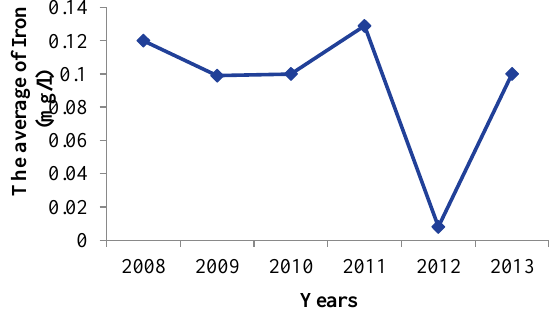
Figure 8. The average of Iron (mg/l) by year 2008-2013 In Birjand and Ghaen, Iran, the average levels of iron and manganese were 0.04 and 0.02 mg/l, respectively. 26 So, the amount of this cation was safe in drinking water in Fereidonkenar as well as Qom, 24 Birjand and Ghaen, 26 Ardebil, 27 Ilam (0.07 mg/l), and Shush and Andimeshk in Khuzestan, 28 Iran. In all of these studies, the average of Fe 2+ concentration was lower than WHO 13 and Iranian 23 standard (0.3 mg/l for iron).